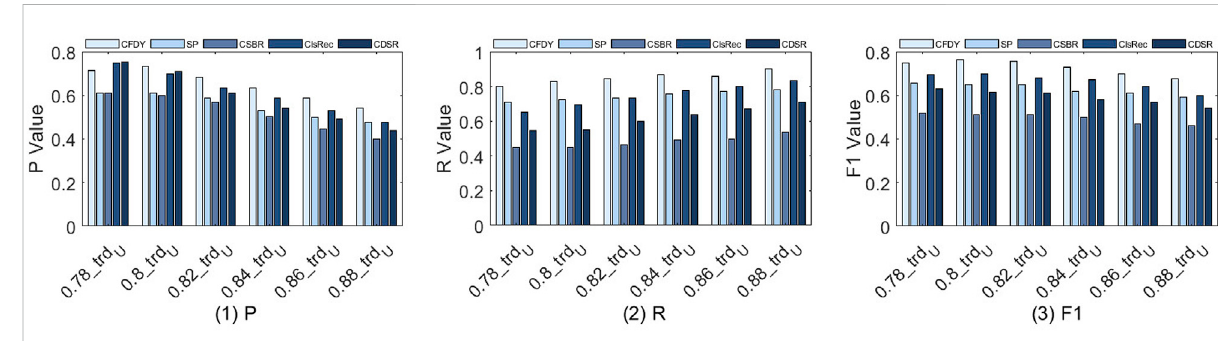
FIGURE 4 P , R , and F1 valuefor thefragmentdiscovery whenthe connection-aware thresholdisset to 0.78, 0.80, 0.82,0.84, 0.86, and